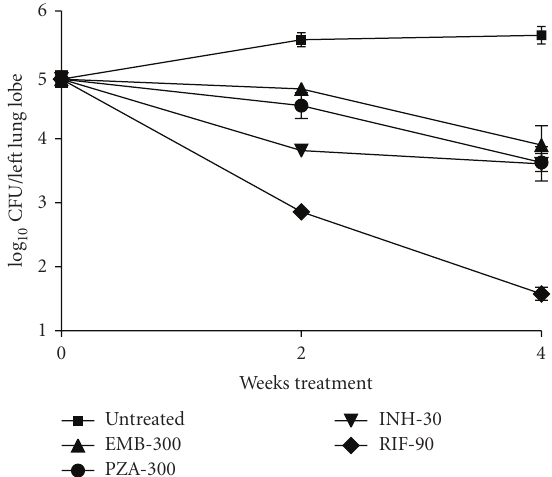
Figure 4: Time course of e ff ect of front-line TB drugs on rat lung infection (RIF-90mg/kg; INH-30mg/kg; EMB 300 mg/kg and PZA 300 mg/kg). Drug treatment was given per oral once daily for 2- and 4-week Figure 3: Dose response of front-line TB drugs in rats following CFU counts/left lung lobe plotted against two-week treatment. log 10 a range of drug regimens. Rifampicin (30, 90 and 270mg/kg), Isoniazid (10, 30, and 90 mg/kg), Ethambutol (100, 300, and 1000 mg/kg) and Pyrazinamide (300 and 1000 mg/kg) were dosed per oral once daily for two weeks (12 doses). Each bar represents the mean CFU counts from three animals.